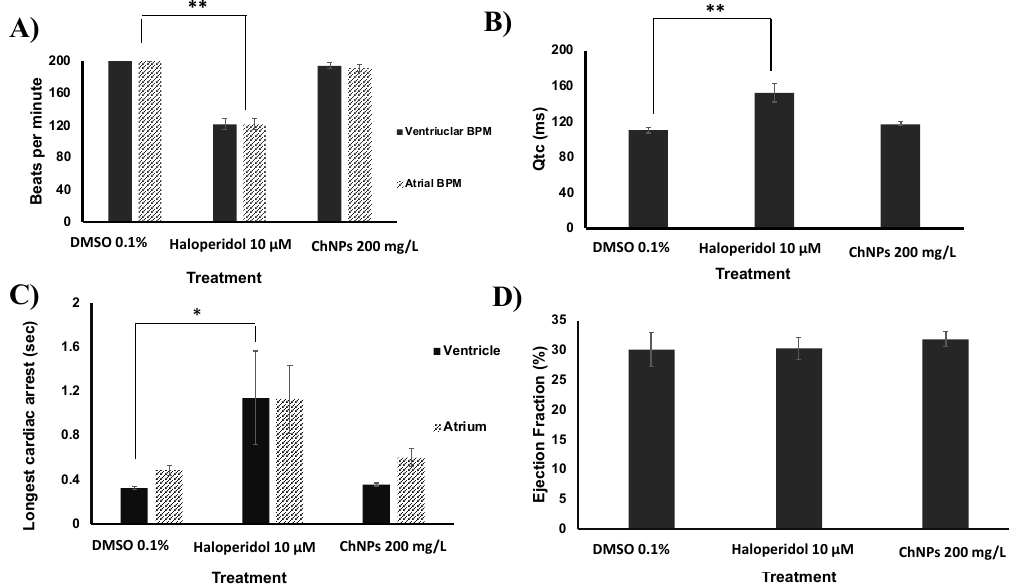
Figure 5. Cardiotoxicity assays. ( A ) Heartbeat rate. ( B ) QTc corrected interval. ( C ) Maximum cardiac arrest. ( D ) Ejection fraction. Ten embryos were used for each treatment concentration.